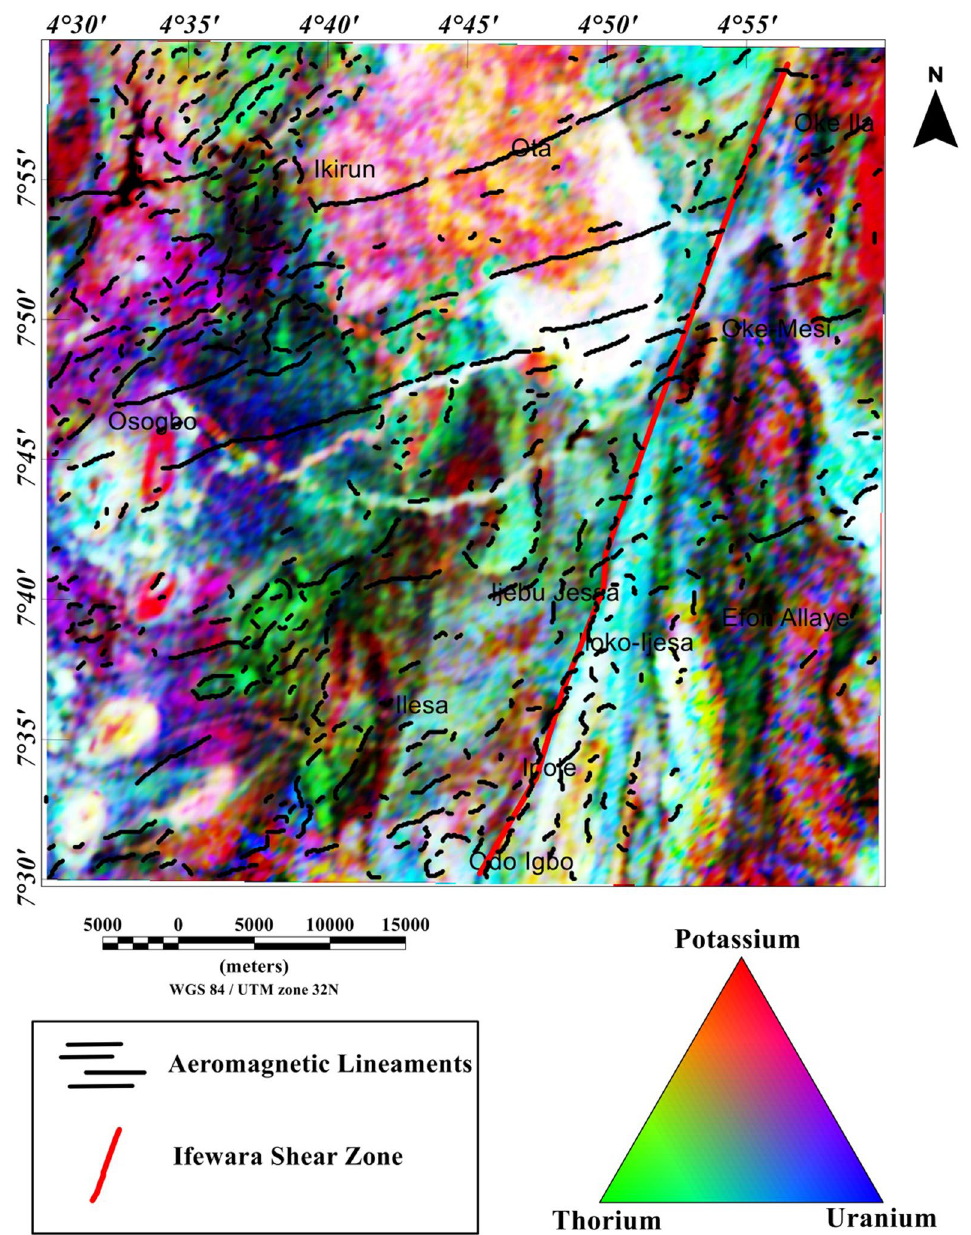
Figure 18. Ternary map of the Ife-Ilesha schist belt produced from the radiometric data of the region. The black and red lines show the aeromagnetic lineaments and Ifewara shear zone respectively, extracted from the total gradient amplitude map. The figure was produced using Oasis Montaj Software version 8.3.3 (Website: https:// www. seequ ent.